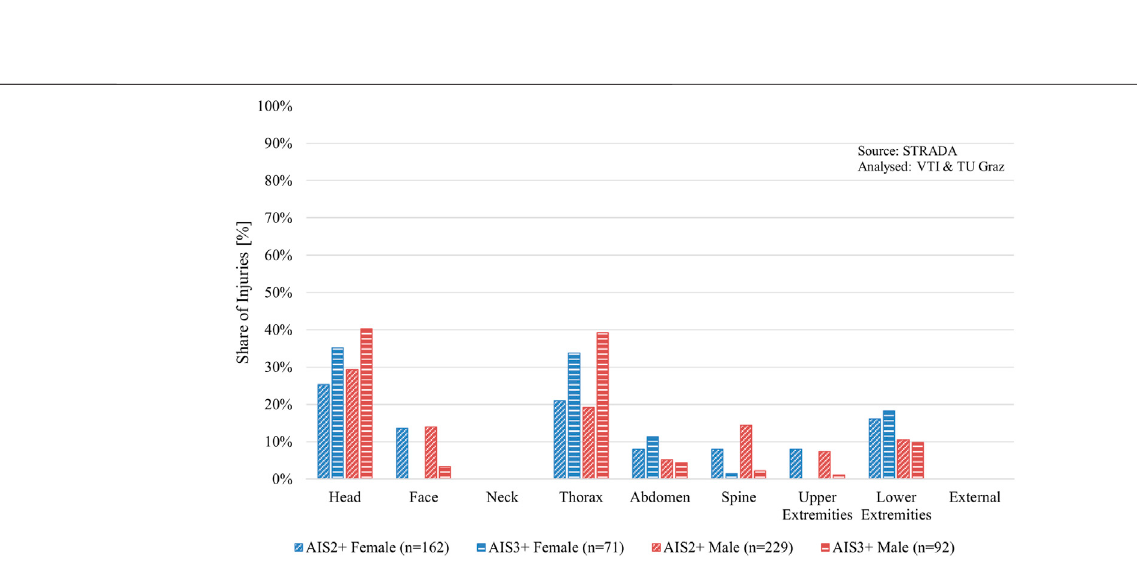
Frontiers in Future Transportation |